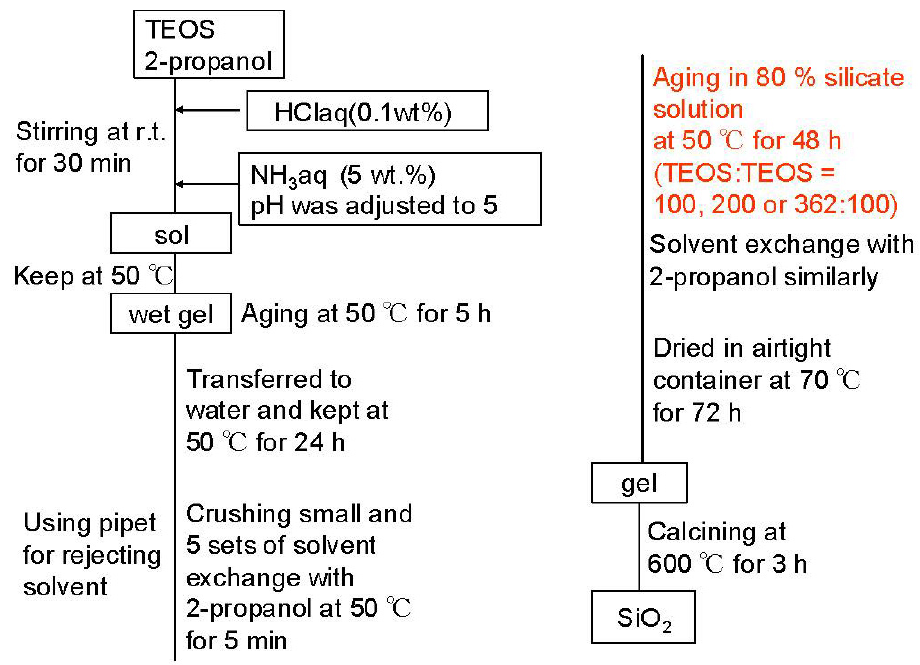
Figure 1. Flowchart for preparation of SiO